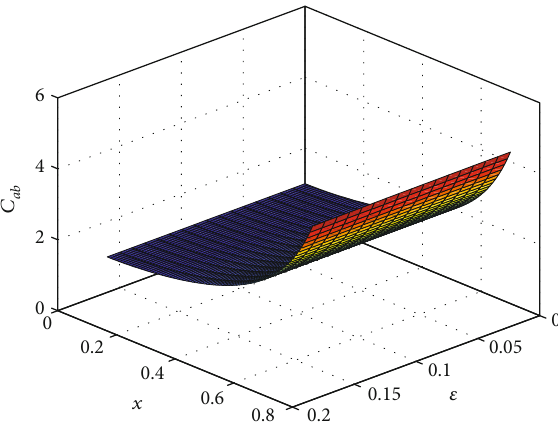
Figure 12: The steady state photon number correlation function of the two-mode cavity radiation versus the initial preparation C ab of atoms x and amplitude of parametric ampli fi er ε for A = 100 , κ = 0 : 5 , and ε = 0 : 06 .